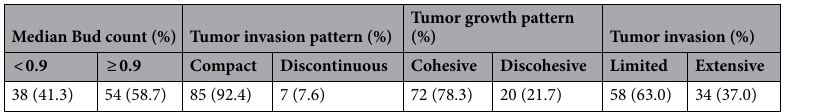
Tumor growth pattern (%) Tumor invasion (%)